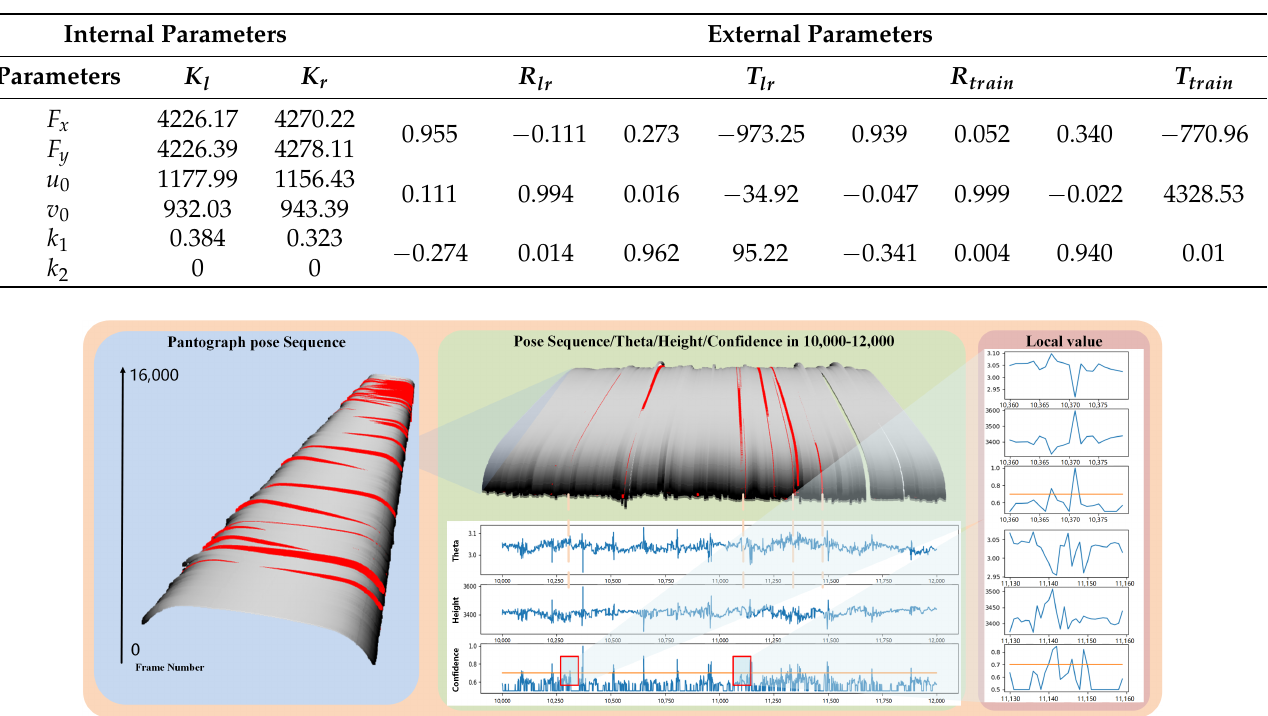
Figure 10. Pantograph pose in frame sequence, in which the left part is the pantograph moving trajectory and the right part shows the details in 10,000–12,000 frames. The top is the lateral view and the bottle, and in below is the theta and height value of the pantograph,